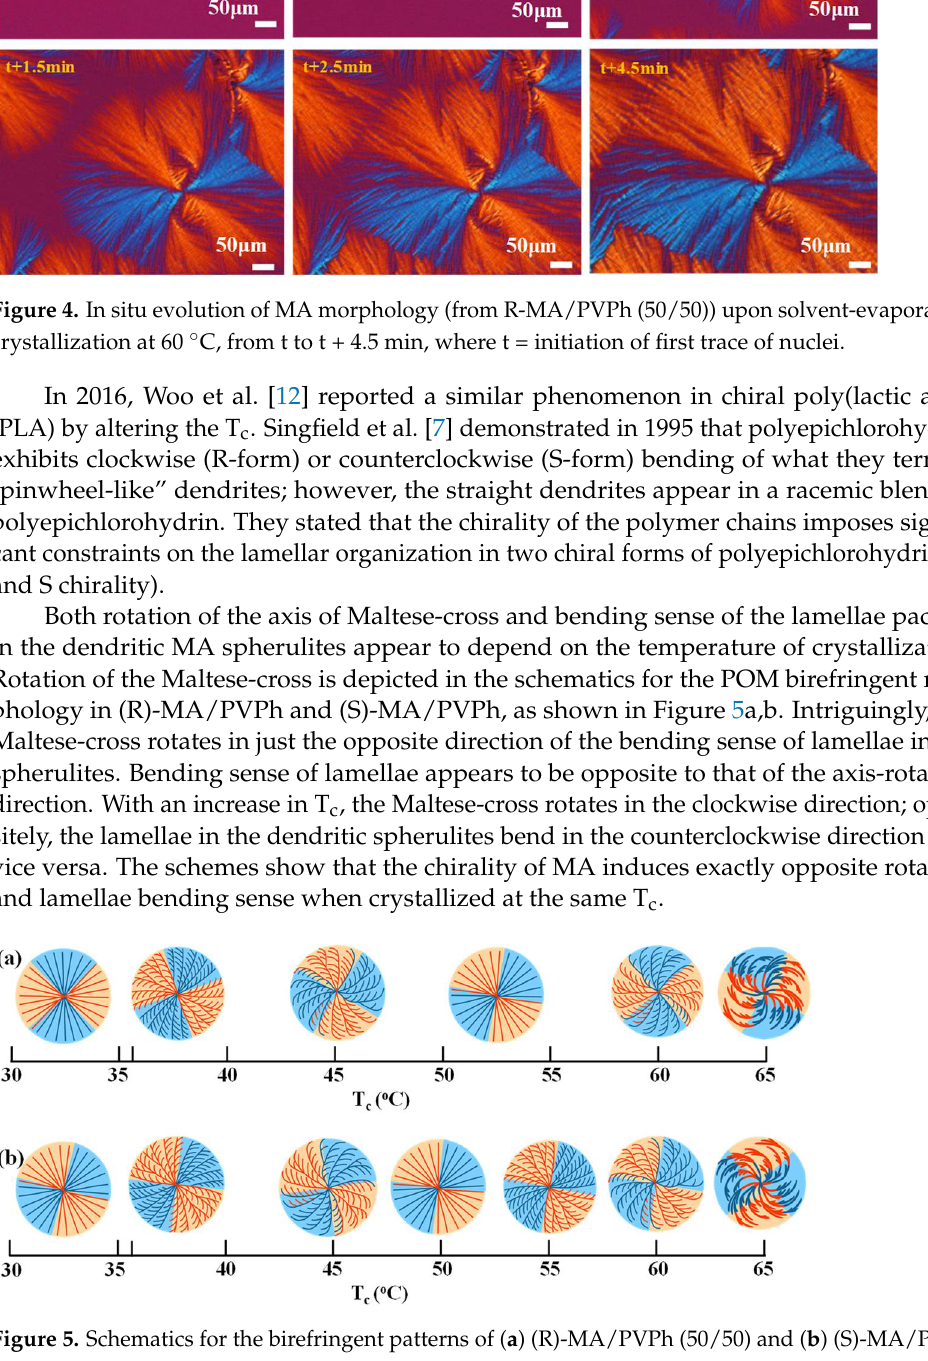
Figure 5. Schematics for the birefringent patterns of ( a ) (R)-MA/PVPh (50/50) and ( b ) (S)-MA/PVPh (50/50) blend at different crystallization temperatures. Apart from that, various thicknesses of samples were used to clarify the bending sense on the MA crystalline morphology. We can conclude from Figure 6a,b that bending